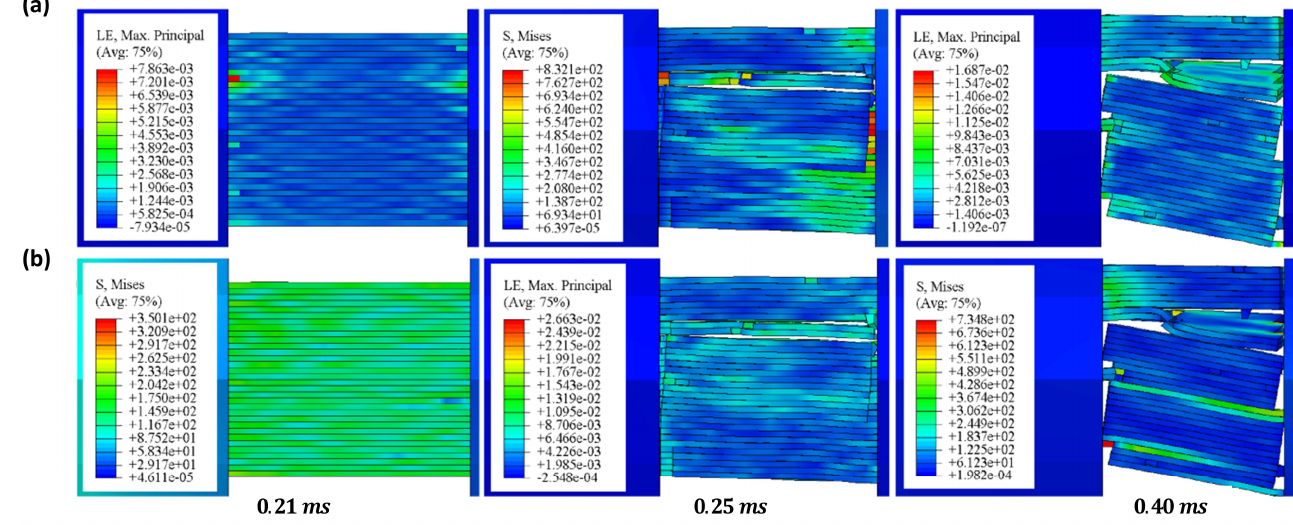
Figure 12. The FEA results of dynamic compression samples of CFRP laminates under 1600 ⁄ s strain rate compression: ( a ) strain nephogram, ( b ) stress nephogram.